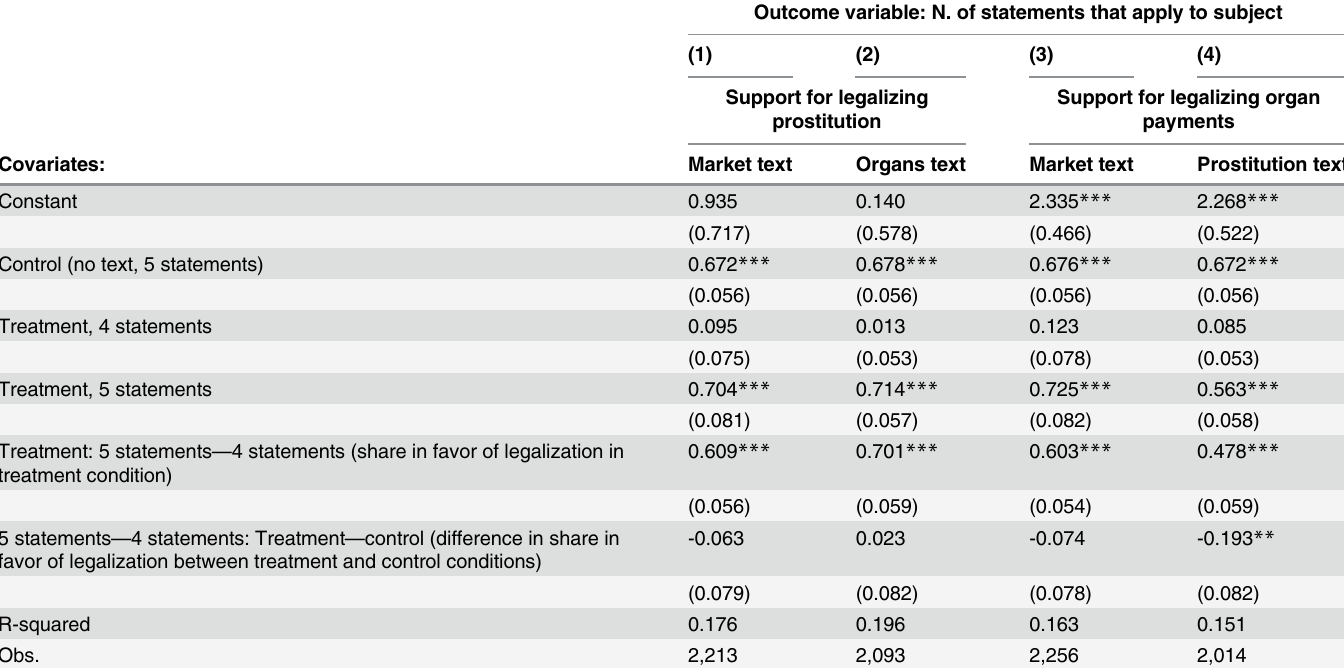
Table 3. Regression estimates.